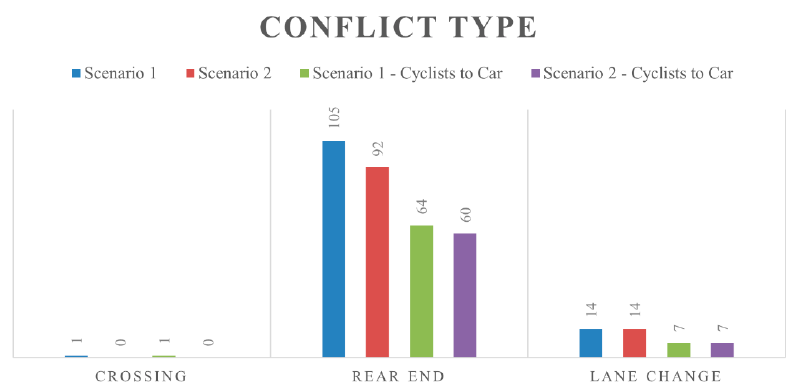
Figure 11. Number of conflicts by type.